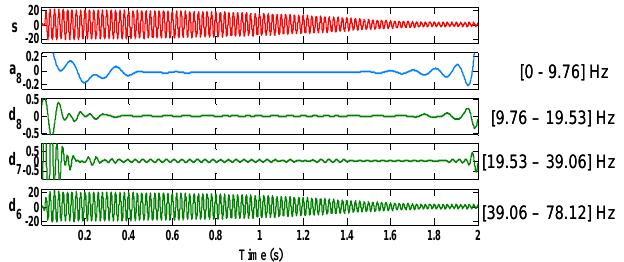
Fig. 9. FFT of the steady state current for the unloaded machine with one broken